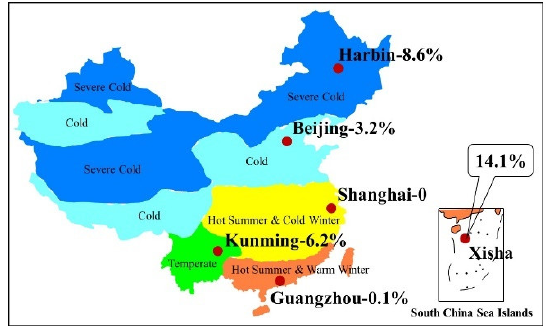
Figure 9. Statistical result of high wind speed proportions among different cities.